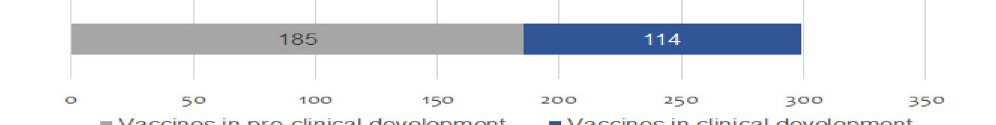
Table 2 Potential SARS-CoV-2 vaccine candidates in preclinical/clinical development [17]: different SARS-CoV-2 vaccine platforms in pre- clinical and clinical development